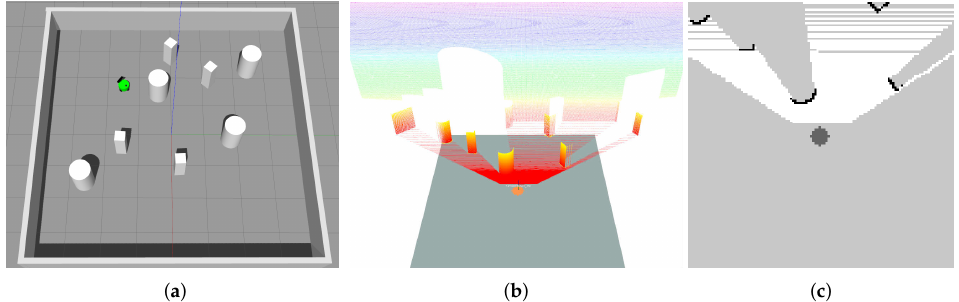
Figure 13. ( a ) An environment contains a robot (green) with a depth camera and randomly placed obstacles (white) in Gazebo. ( b ) Point cloud data generated by the depth camera with 120-degree FOV. ( c ) The grid map generated from the point cloud data.